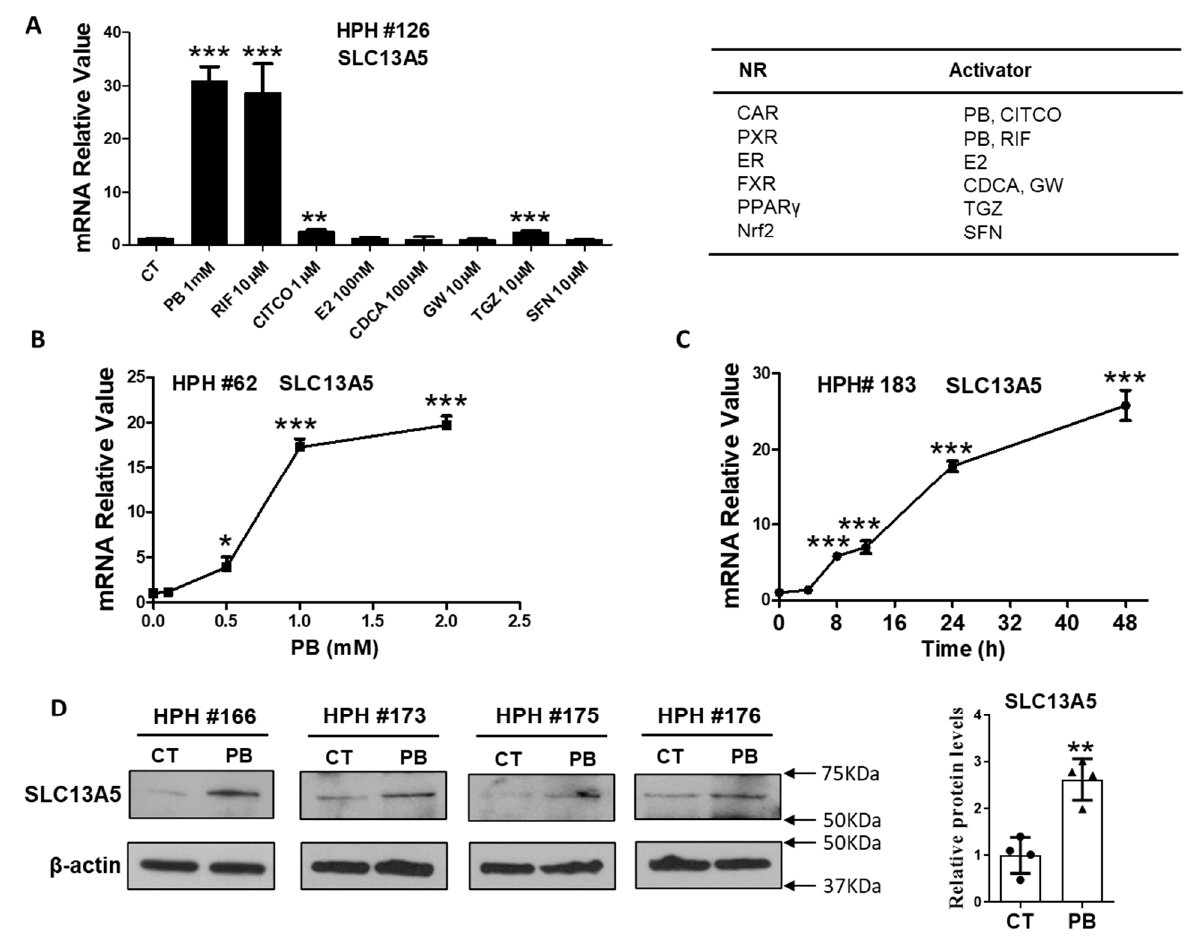
Figure 1. PB induces SLC13A5 expressions in HPH. Human hepatocytes prepared from liver donors (HPH #126) were treated with multiple nuclear receptor activators for 24 h as indicated. The expression of SLC13A5 mRNA was measured using RT-PCR assays ( A ). Concentration- ( B ) and time-dependent ( C ) induction of SLC13A5 mRNA by PB was detected using RT-PCR in HPH from liver donors #62 and #183, respectively. In separate experiments, HPH from liver donors (#166, #173, #175, and #176) were treated with vehicle control (CT) or PB (1 mM) for 48 h to analyze proteins by western blot assay ( D ). Data are expressed as mean ± S.D. ( n = 3–4), * p < 0.05; ** p < 0.01; *** p < 0.001.